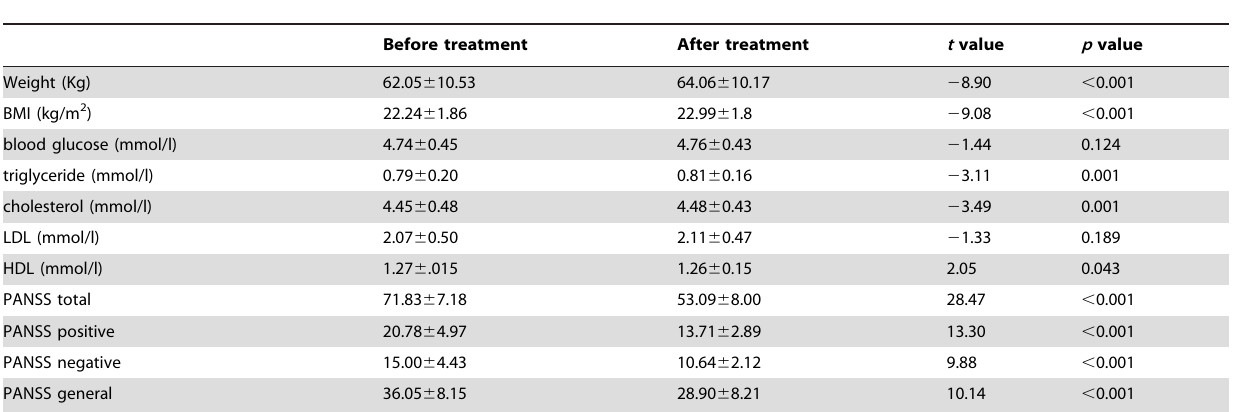
Table 2. Clinical measures before and after 8 weeks of risperidone treatment (N